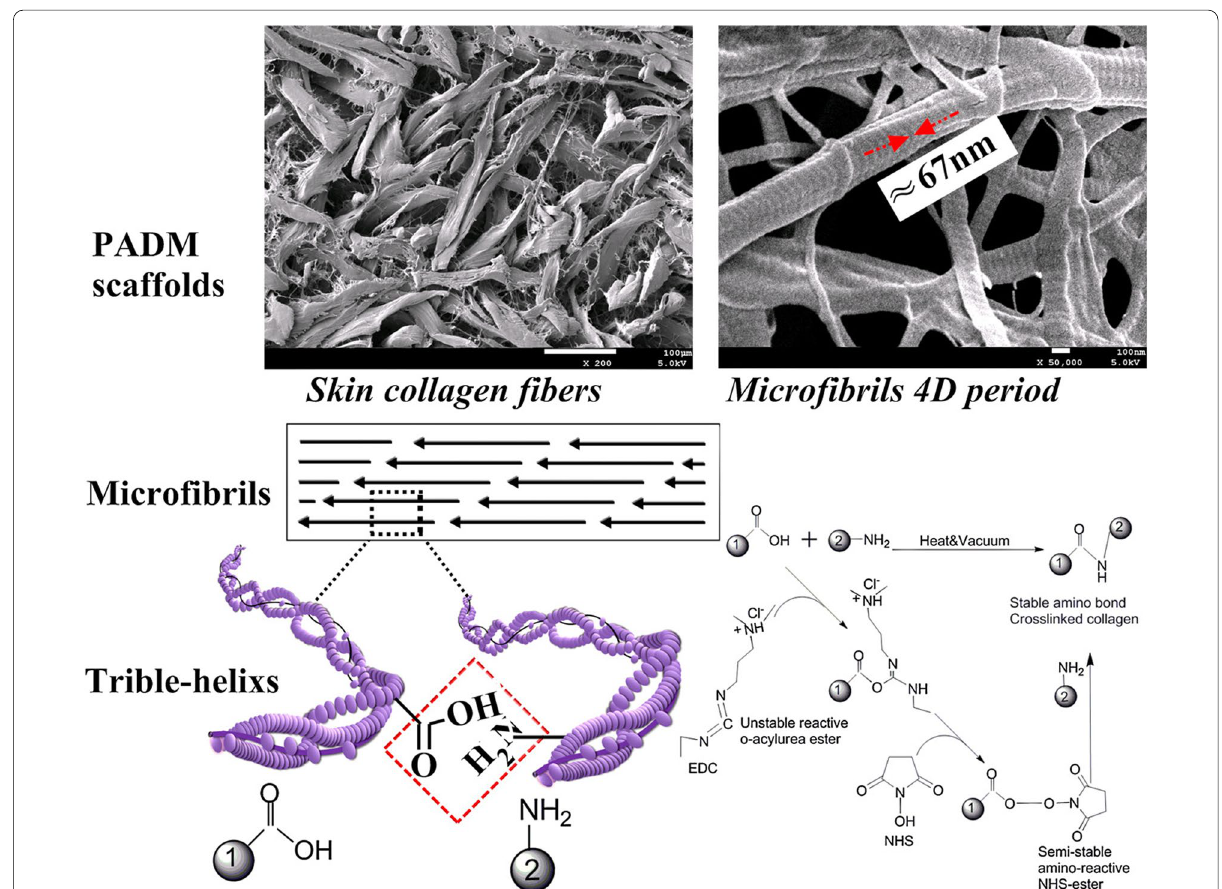
Fig. 3 The diagarm of the mechanism of synergistic effect of EDC and dehydrothermal crosslinking on porcine ADM (PADM). ( Adapted from ref. [36], copyright 2013, with permission from the